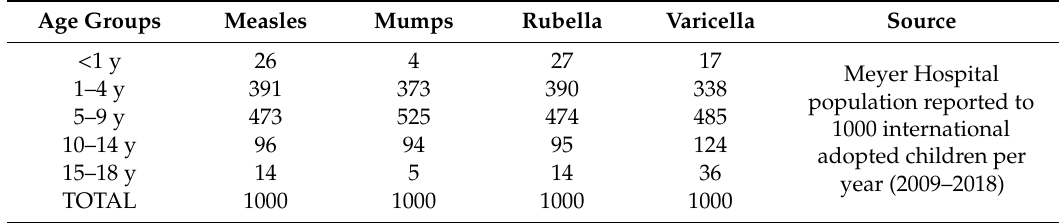
Table 1. Study population according to age-groups and vaccine preventable disease reported to a population of 1000 internationally adopted children (IAC) per